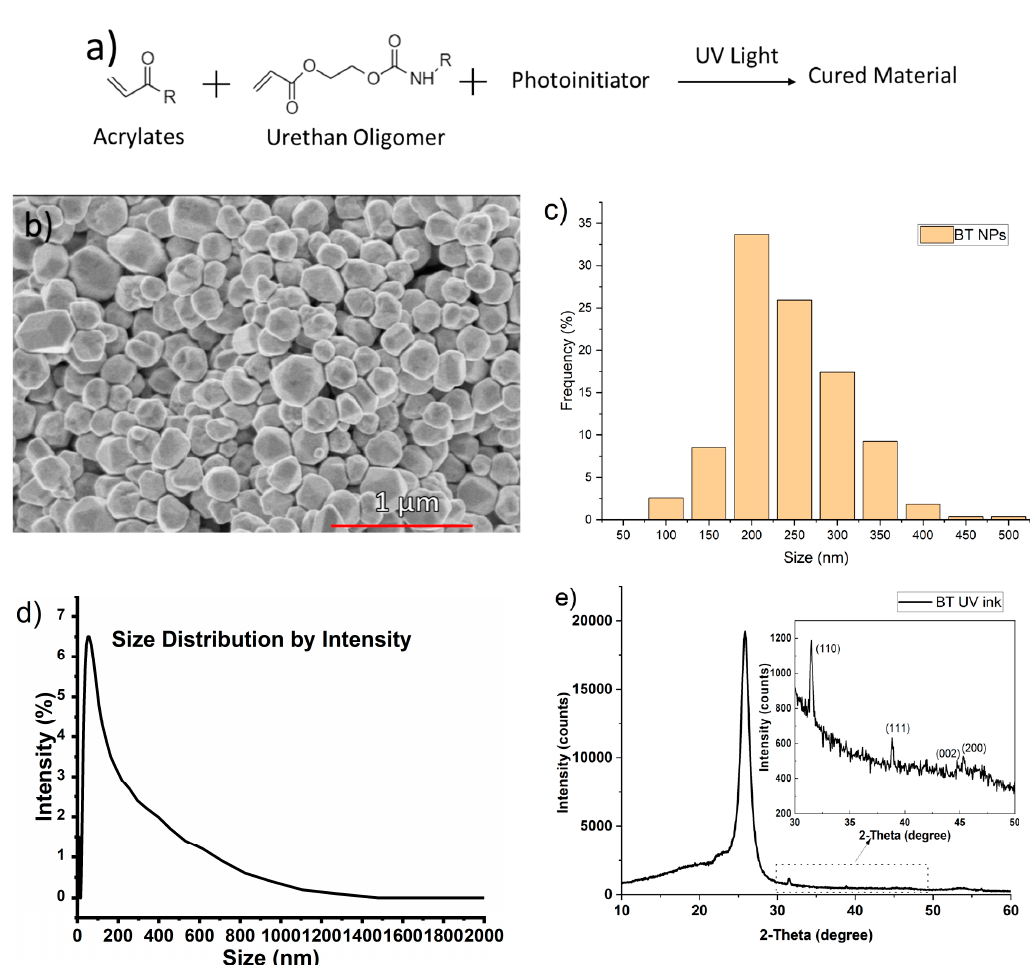
Figure 3. Fundamental characteristics of UV-curable ink with BT nanoparticles. ( a ) Chemical reaction mechanism of acrylate and urethane UV-curing process [43] . ( b ) Scanning electron microscopy (SEM) of BT nanoparticles (50,000×; 1 μ m of scale bar). ( c ) Size distribution of the BT nanoparticles. ( d )